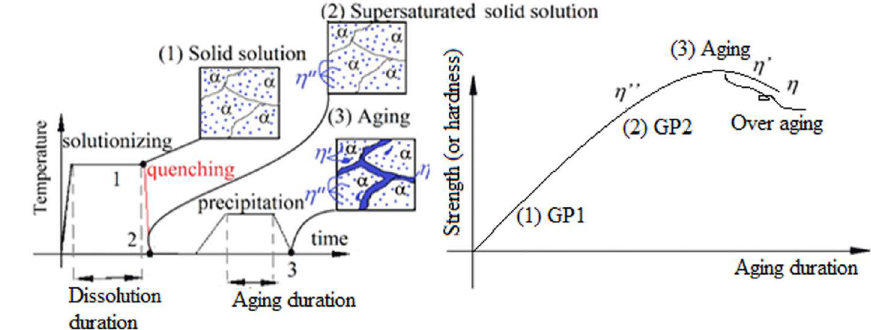
Figure 1. Sub steps of the aging process and phase transitions with respect to aging